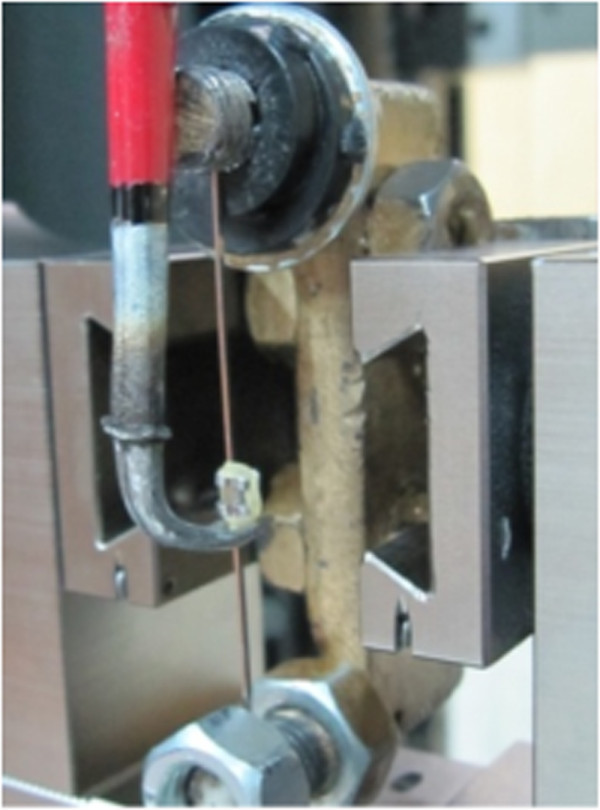
Friction testing apparatus.